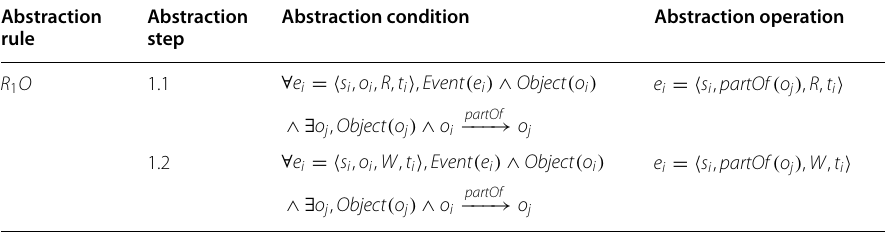
Table 7 Abstraction rules of